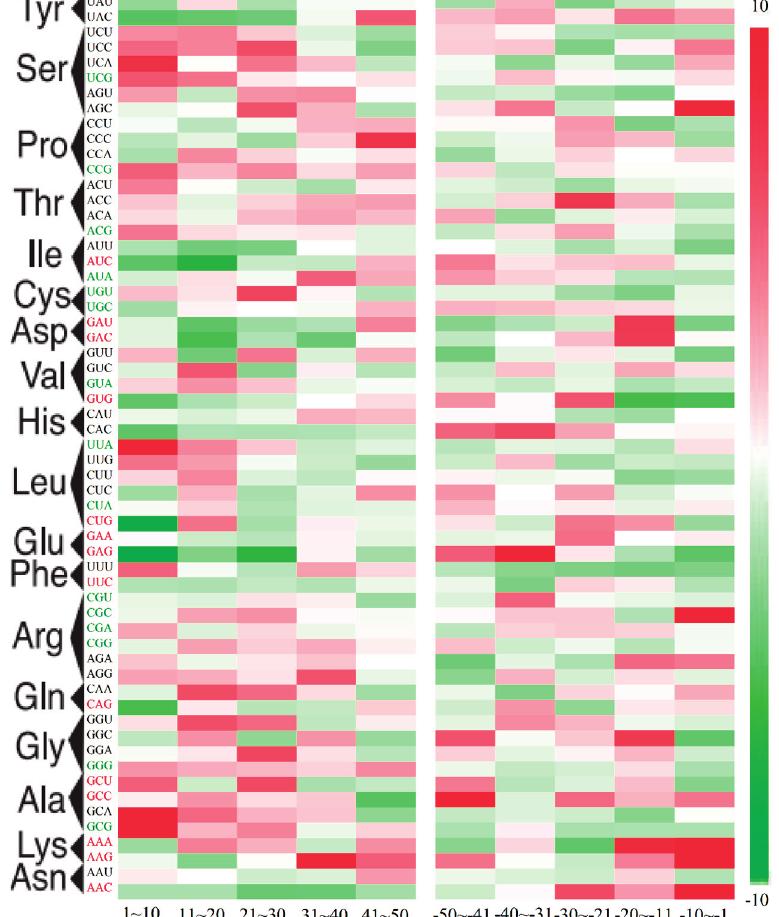
Figure 3. Position-dependent codon usage bias in M. amblycephala . KLD value for each codon in M. amblycephala is depicted according to the scaled color bar on the right as a function of position: 5 bins following the start codon and 5 bins before stop codons. Rare codons and abundant codons are marked green and red,